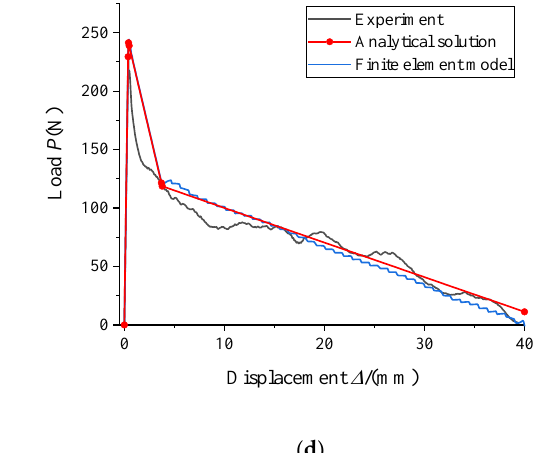
Figure 21. Load–displacement curves from the pullout tests, analytical solutions and FE simulations (group Z): ( a ) Z1: Z6011; ( b ) Z2: Z6020; ( c ) Z3: Z6030; ( d ) Z4: Z6040.